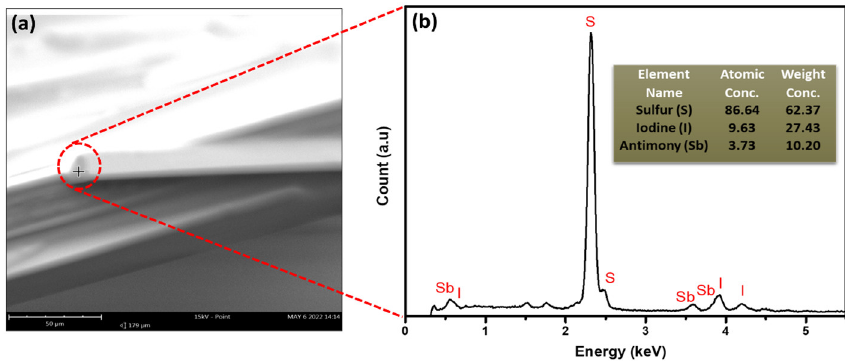
Figure 6. ( a ) SEM image of SbI 3 · 3S 8 crystal and ( b ) energy-dispersive X-ray spectroscopy (EDS) of SbI 3 · 3S 8 crystal (inset of the EDS spectrum demonstrates the atomic concentration and weight concentration of each element present in the crystal).